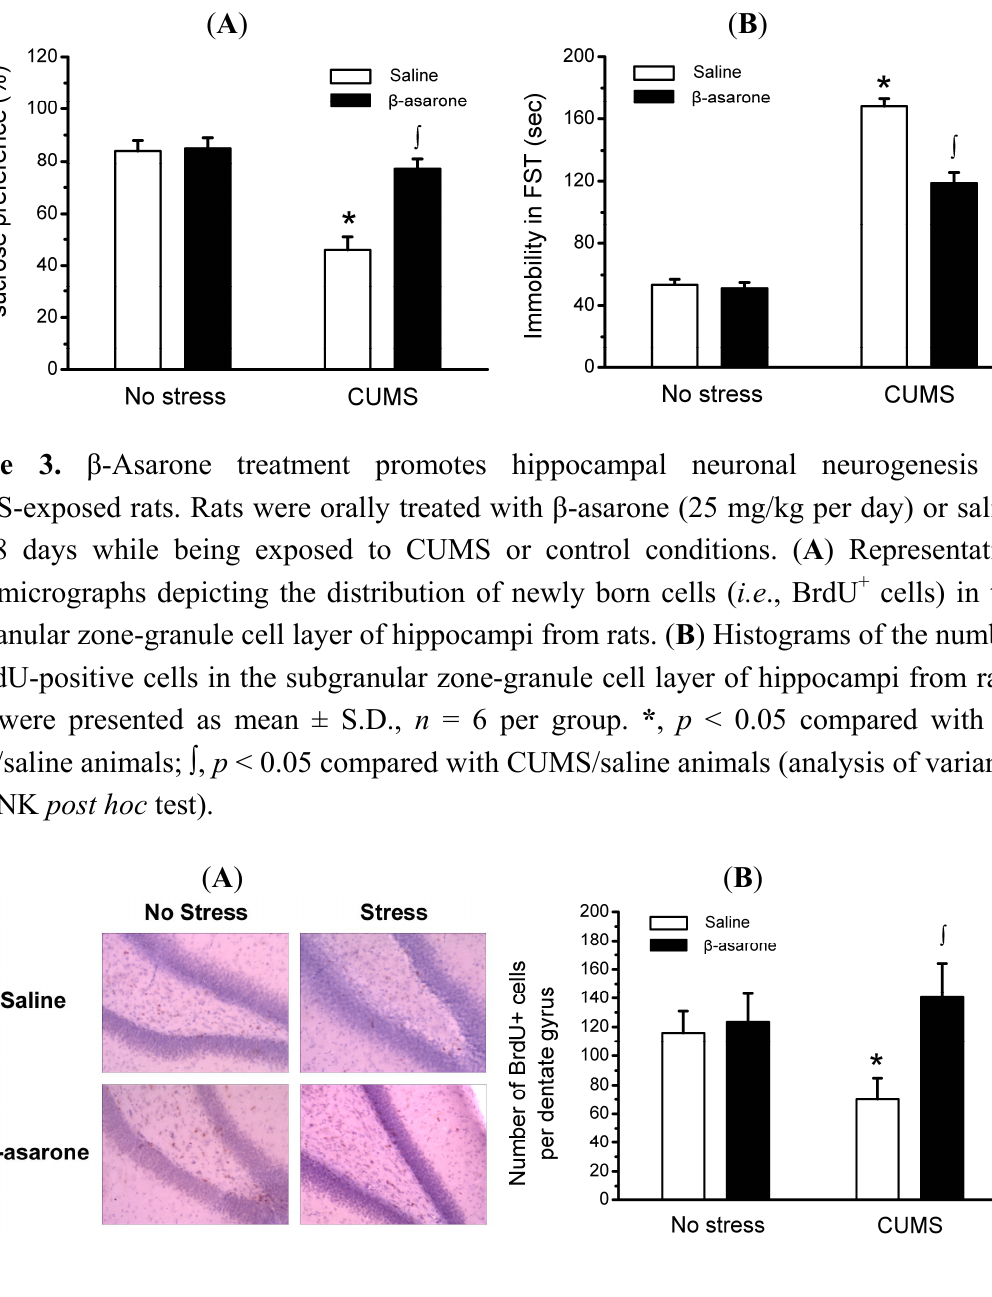
Figure 2. β -Asarone treatment produces antidepressant-like behavioral effects in CUMS-exposed rats. Rats were orally treated with β -asarone (25 mg/kg per day) or saline for 28 days while being exposed to CUMS or control conditions. ( A ) a two-bottle preference test was used to evaluate the sucrose preference, and which were expressed as a ratio of the volume of sucrose solution consumption to the volume of total fluid intake. ( B ) the forced swimming test was used to evaluate the depression-related behavior. Note that CUMS-exposed rats receiving β -asarone displayed decreased immobile time and preference for sucrose, while immobile time and preference for sucrose in β -asarone- treated rats not different from no stress rats. Data were presented as mean ± S.D., n = 15 per group. * , p < 0.05 compared with no stress/saline animals;  , p < 0.05 compared with CUMS/saline animals (analysis of variance and SNK post hoc test).